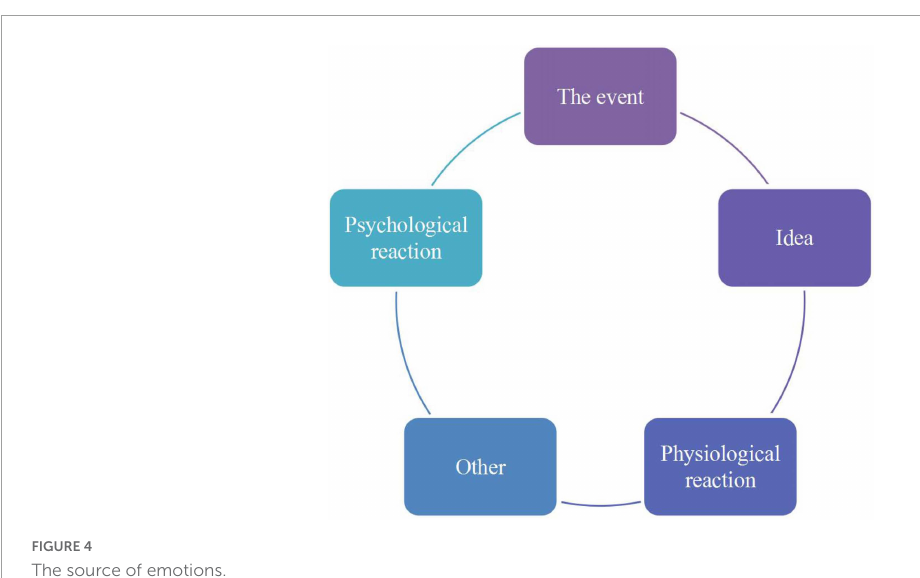
FIGURE4 The source of